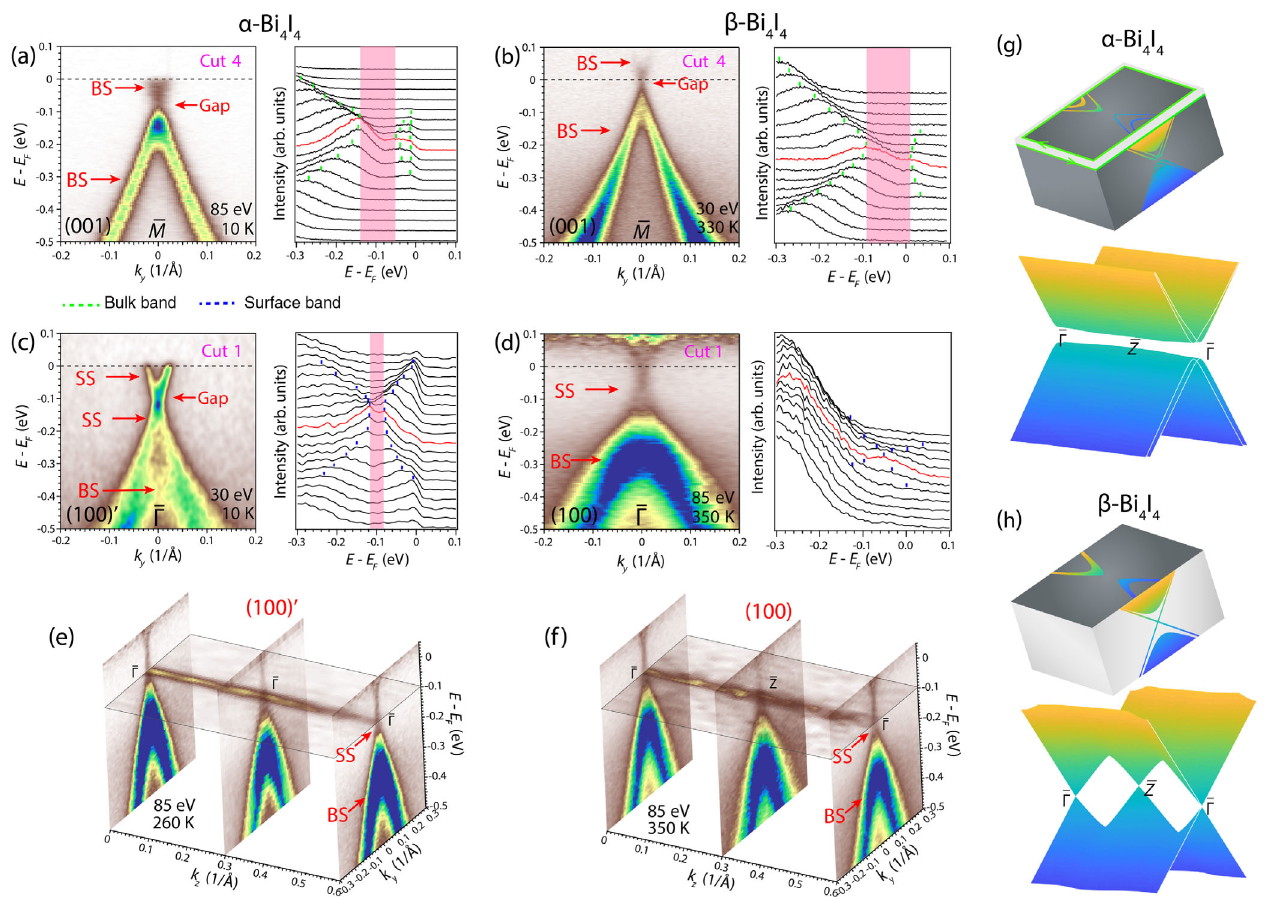
FIG. 4. Surface states evolution across the phase transition. (a) Band image along cut 4 on the (001) surface indicated in Fig. 2(b) of α -Bi k ¼ 0 . The green dots track the peak positions of the bulk 4 I 4 as well as its corresponding EDC stacks. The red EDC corresponds to band which reveal a gap opening of ∼ 85 meV. (b) Same as (a) but of β -Bi 4 I 4 . A gap opens at k ¼ 0 of ∼ 100 meV. (c) Band image along cut 1 on the ð 100 Þ 0 surface indicated in Fig. 2(a) of α -Bi 4 I 4 as well as its corresponding EDC stacks. The blue dots track the surface state which reveal a ∼ 35 meV gap opening. (d) Same as (c) but of β -Bi 4 I 4 . A gapless Dirac surface state is observed. (e) 3D view of the electronic structure on the ð 100 Þ 0 surface of α -Bi 4 I 4 . A quasi-1D Dirac-like surface state is observed. (f) Same as (e) but of β -Bi 4 I 4 . The quasi-1D Dirac surface state reveals the weak TI property. (g) Schematics (see Supplemental Material [33]) showing the higher-order TI state of α -Bi 4 I 4 with a particular surface termination. Upper panel: all the bulk states and surface states are gapped, whereas a helical hinge state around the top surface exists in the surface state gap. Lower panel: the enlarged ð 100 Þ 0 surface state features a band doubling and a small gap. (h) Schematics (see Supplemental Material [33]) showing the weak TI state of β -Bi 4 I 4 . Upper panel: the bulk states and (001) surface state are gapped, whereas there is a quasi-1D gapless Dirac surface state on the (100) surface. Lower panel: the enlarged (100) surface state features two gapless Dirac